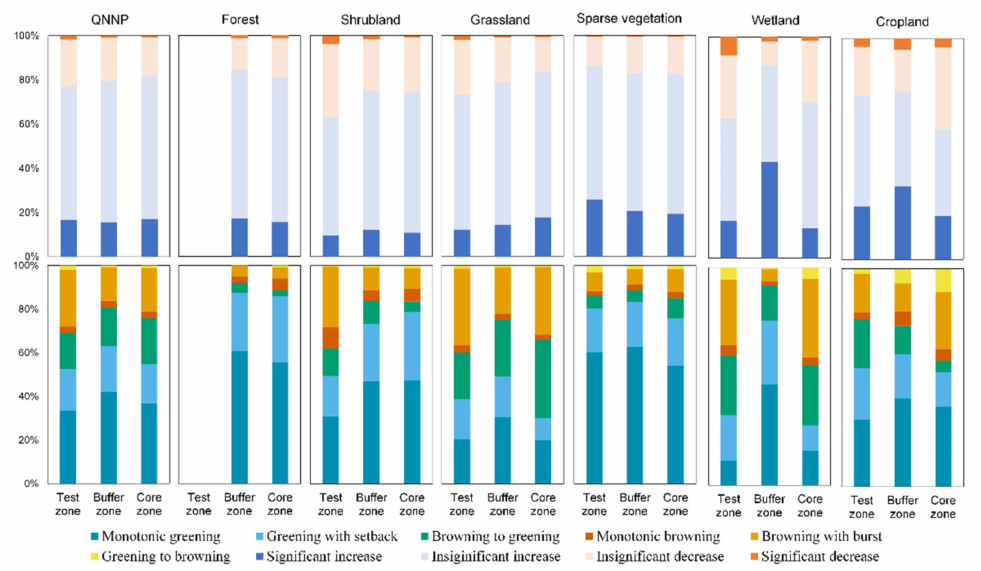
Figure 13. Proportions of the types of variation and shift for different vegetation types in the three